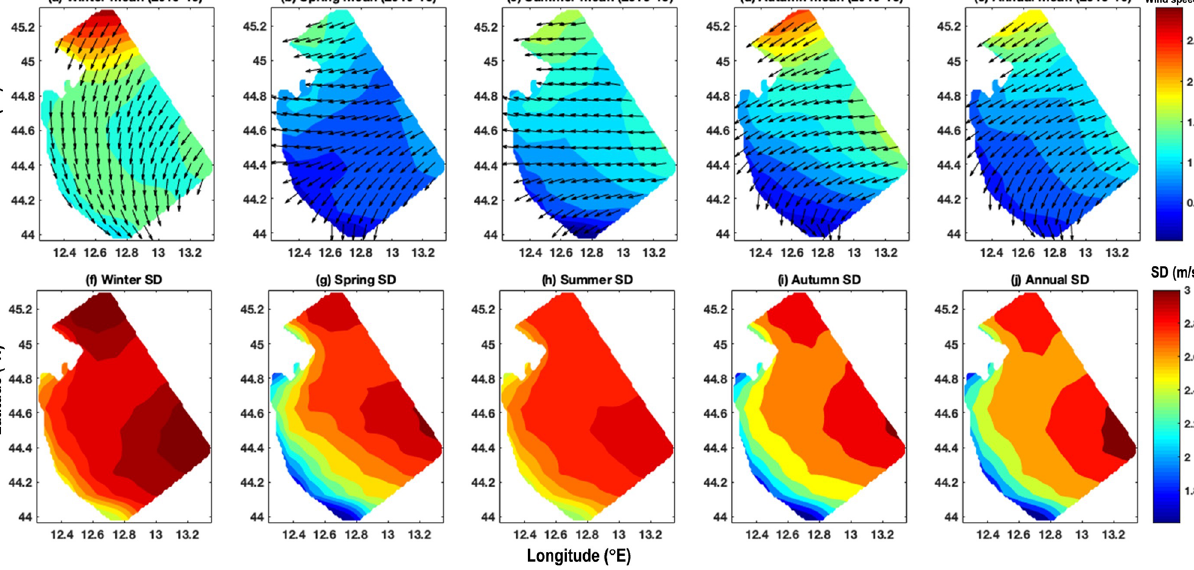
Figure 4. Wind climatology for the Emilia-Romagna region based on ECMWF analysis wind data for 2010 to 2019. Mean wind speed and direction for (a) winter, (b) spring, (c) summer, (d) autumn, and (e) annual periods (top panels). The lower panels show the standard deviation (SD) of wind speed for (f) winter, (g) spring, (h) summer, (i) autumn, and (j) annual